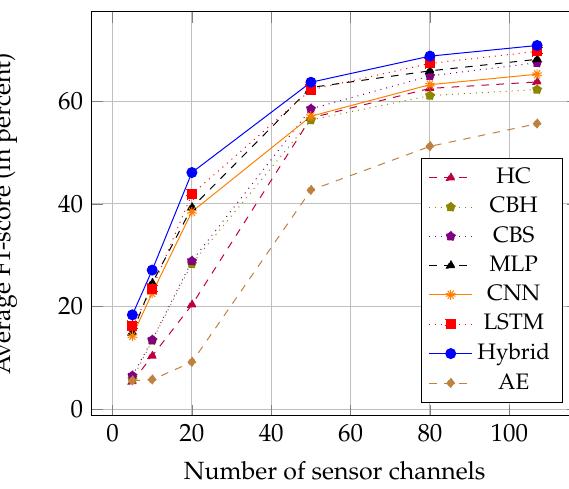
Figure 8. Average F1-scores of the feature learning methods on the OPPORTUNITY dataset, using different numbers of sensor channels (ranked by decreasing